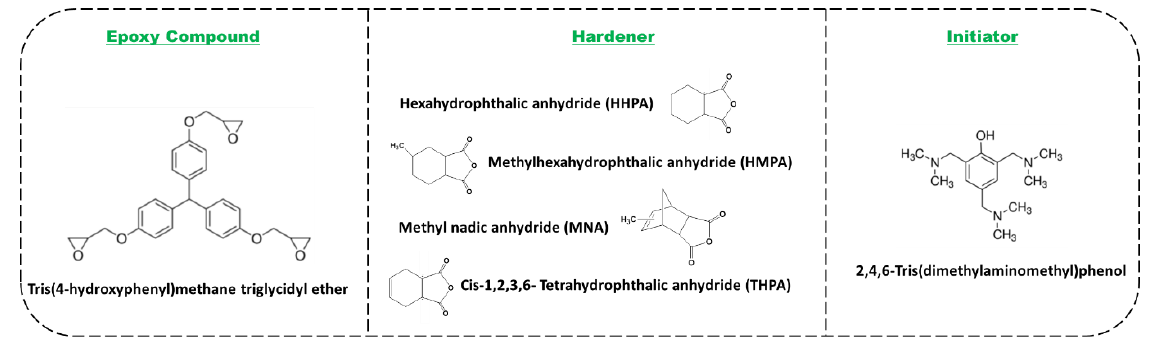
Figure 1. Molecular structures of the used compounds.